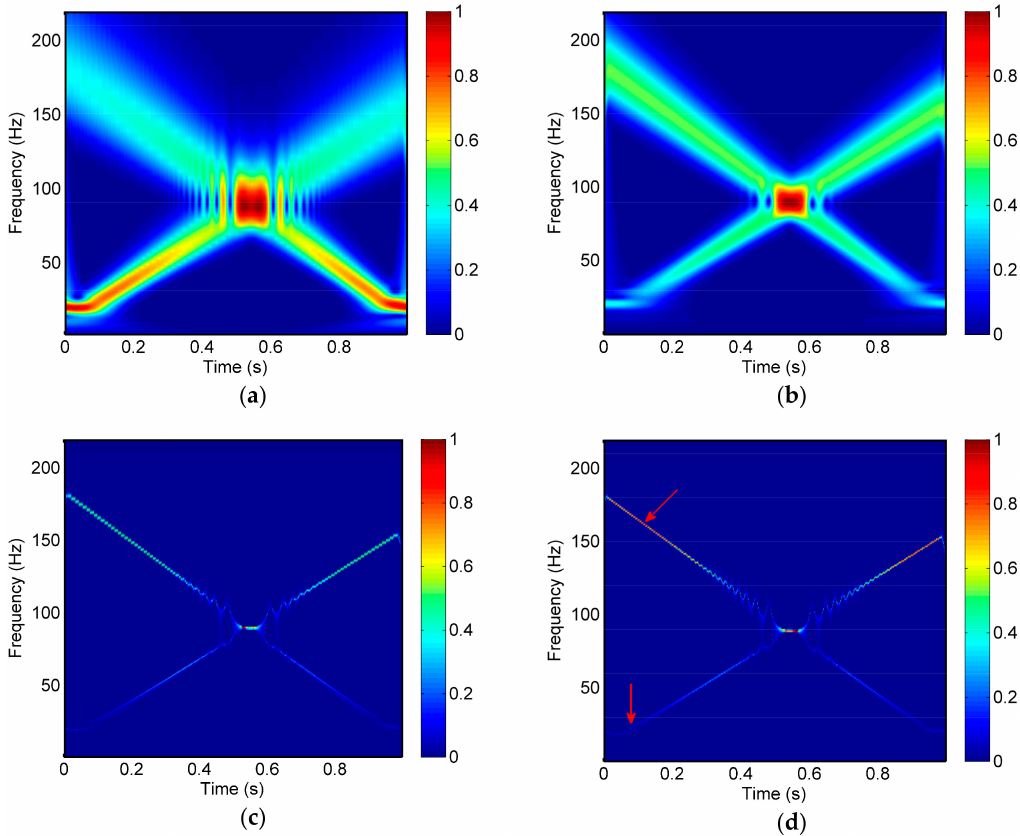
Figure 2. Time-frequency spectra of the double linear chirped signal based on ( a ) Continuous Wavelet Transform (CWT), ( b ) Generalized S-transform (GST), ( c ) Synchrosqueezing continuous wavelet transform (SSCWT), and ( d ) Synchrosqueezing generalized S-transform (SSGST).